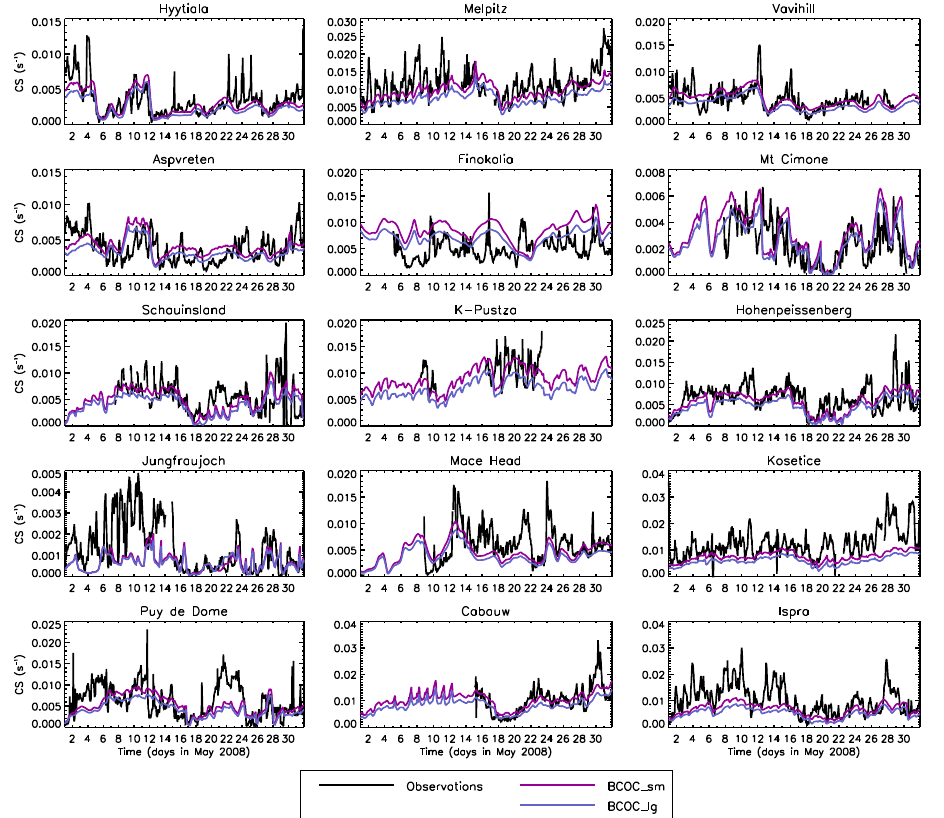
Fig. 12. May 2008 time-series of hourly-mean simulated (colour) and observed (black) condensation sink (CS) at each ground site. Model experiments, BCOC lg and BCOC sm, are described in Table 2.